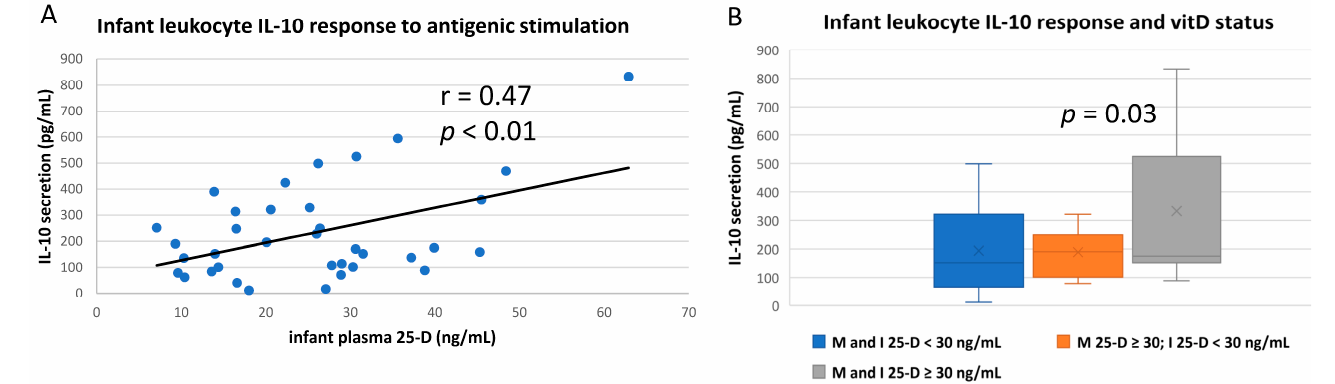
Figure 6. IL-10 responses of infant leukocytes to in vitro antigenic stimulation. Whole blood from breastfeeding infants was antigen-stimulated and culture supernatants analyzed for IL-10 content.